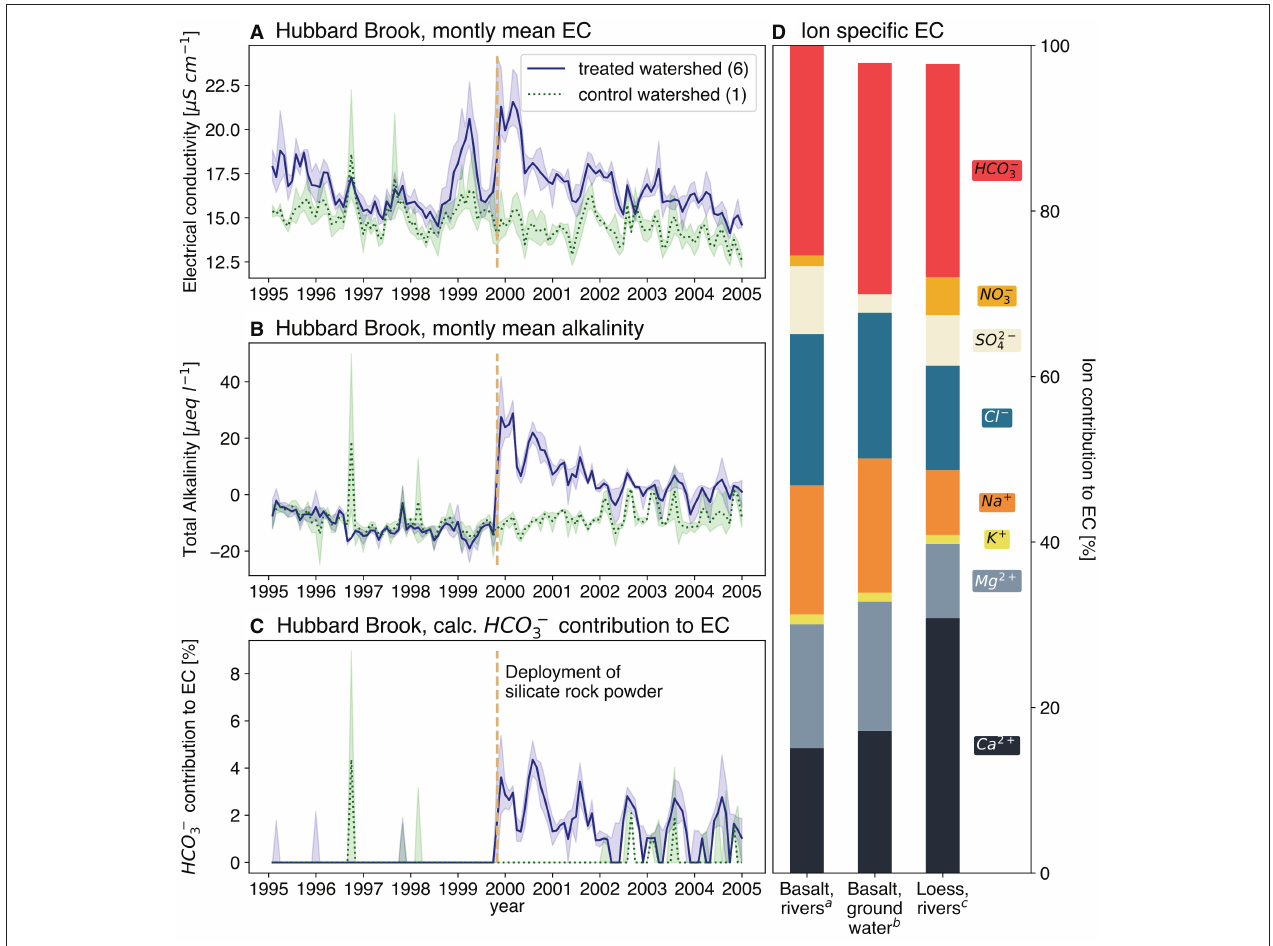
FIGURE 2 | Selective time series of two Hubbard Brook experimental forest watershed (Likens, 2017), watershed 1 data as control baseline (dotted, green) and watershed 6 data representing effects of silicate rock powder spreading (solid, blue): monthly mean and 10 and 90 percentiles for electrical conductivity (A) , total alkalinity (B) and the calculated HCO − 3 contribution to the electrical conductivity (C) ; Individual ionic conductivity contributions to overall electrical conductivity, mean values (D) , individual sample results, can be found in Supplementary Material S4 . a data from rivers of Madeira island, collected by the authors; b data from Van Der Weijden and Pacheco (2003); c data from rivers of a loess dominated catchment in Germany, collected by the authors.